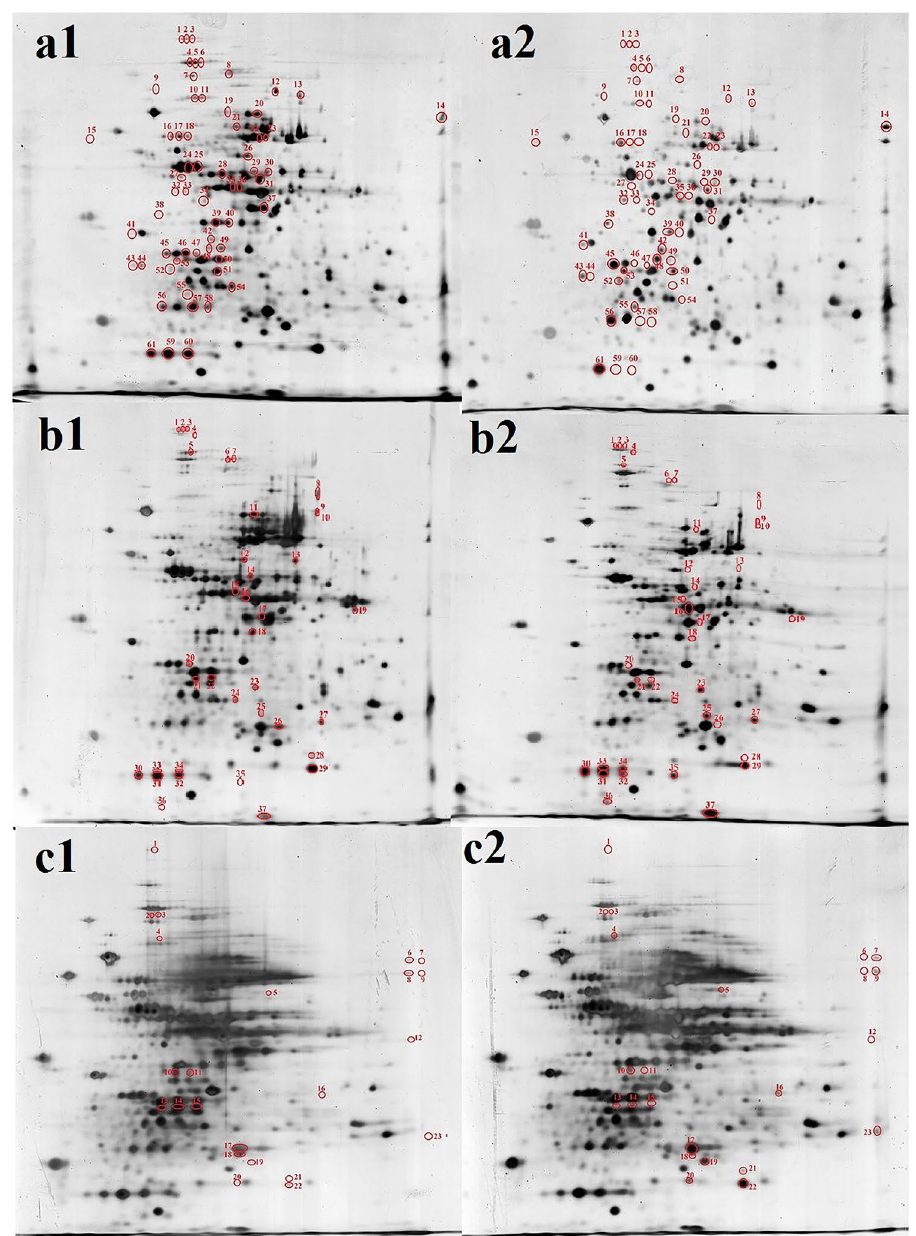
Figure 1. Interaction between TPT and protein primary structures in different conditions. ( a ) silver staining process; ( b ) TPT was added in low melting point agarose gel; ( c ) TPT and denatured proteins mixed in lysis buffer. 1: control samples; 2: experimental